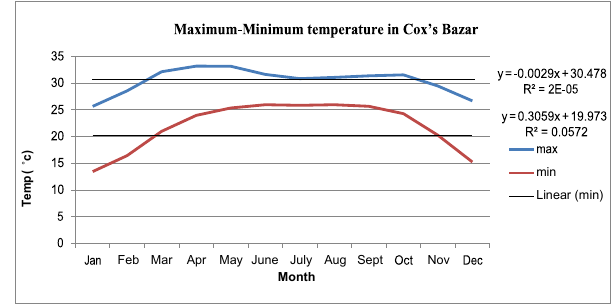
Figure 5: Long term (1950-2010) trend of maximum-minimum